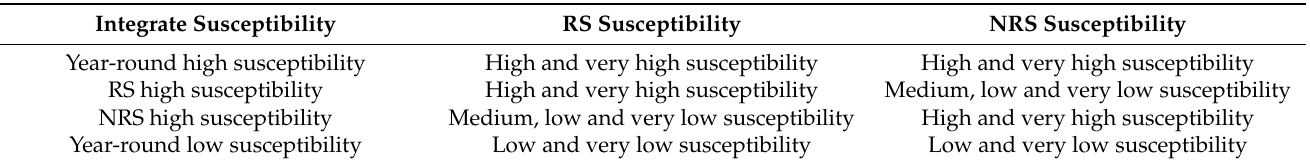
Table 7. Principles of map integration.